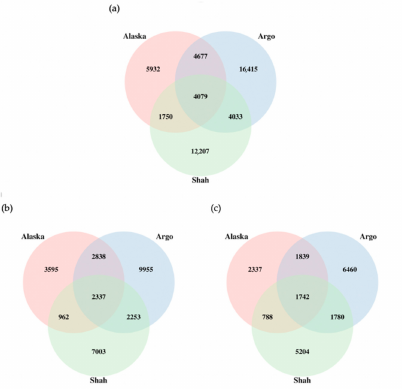
Figure 1. The unique and common SVIM–Sniffles structural variations for different potato varieties. ( a ) All indels; ( b ) deletions; ( c ) insertions.